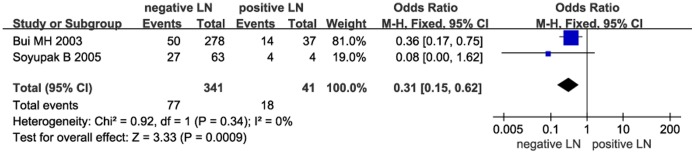
Meta-analysis of the association between low CAIX expression and lymph node metastasis.